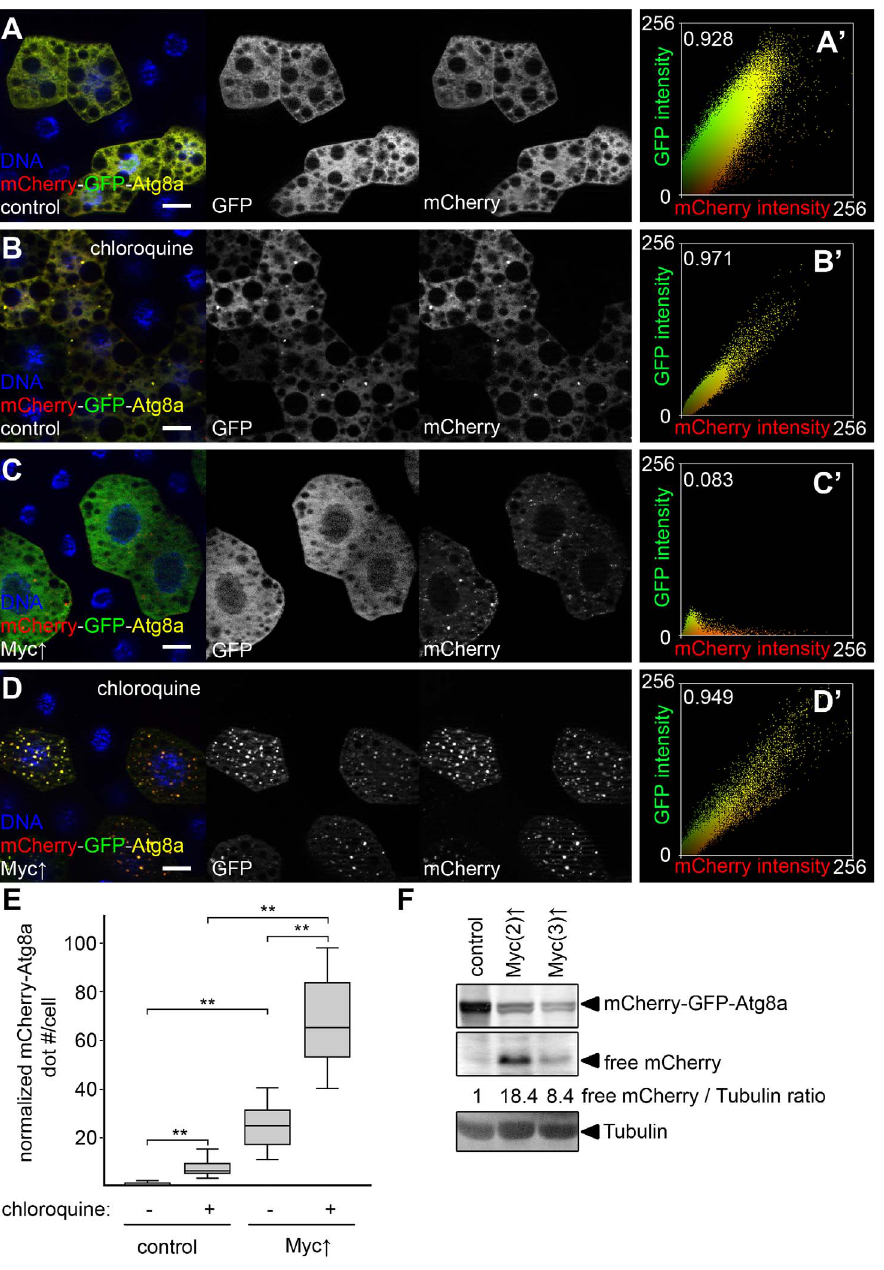
Figure 3. Myc increases autophagic flux. (A) Practically no mCherry-GFP-Atg8a dots are seen in control fat body cells of well-fed larvae. (B) Dots positive for both mCherry and GFP appear in control cells upon feeding larvae chloroquine, a drug that blocks lysosomal degradation. (C) Overexpression of Myc results in the formation of puncta that are mostly mCherry-positive. (D) Chloroquine treatment strongly increases the number of mCherry punctae in Myc overexpressing cells. Note that dots are now positive for GFP as well. (A 9 –D 9 ) Fluorescent intensity and colocalization profiles of mCherry and GFP channels from panels A–D. Pearson correlation coefficients shown in A 9 –D 9 indicate that the correlation of the mCherry and GFP pixel intensity is low in panel C but high in panels A, B, and D. (E) Quantification of data in panels A–D, n=15–30 per genotype/treatment. Myc expression in fat body cells strongly induces mCherry puncta formation compared to control cells. Chloroquine treatment increases dot numbers both in control and Myc overexpressing cells. (F) Autophagic degradation-dependent conversion of mCherry-GFP-Atg8a to free mCherry is increased by overexpression of Myc in fat body cells. Numbers indicate the level of free mCherry relative to the loading control Tubulin in different genotypes, as determined by densitometric evaluation. Scalebars in A–D equal 20 m m. Statistically significant differences are indicated, ** p , 0.01.